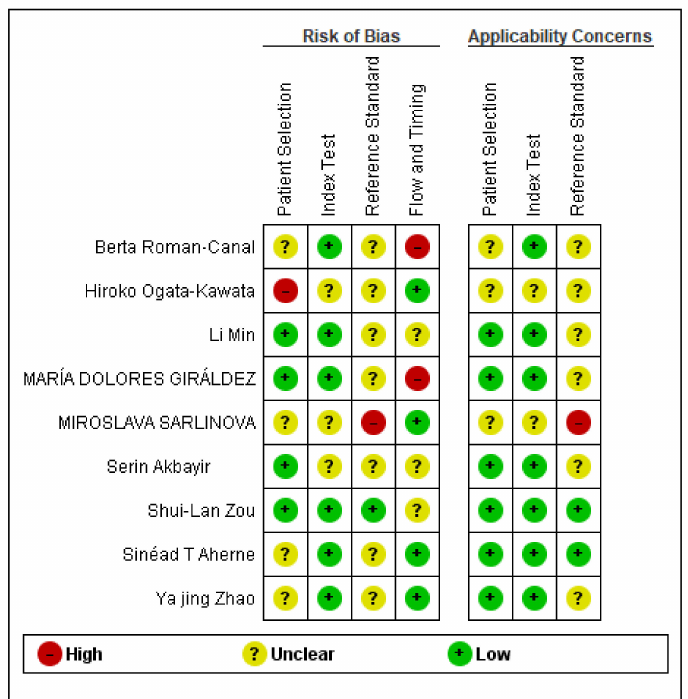
Figure 5. Risk of Bias and Applicability Judgments according to